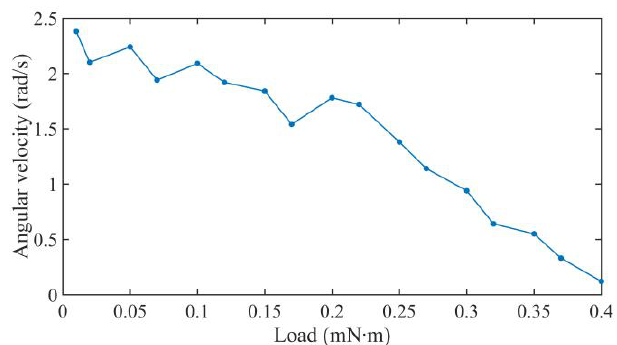
Figure 15. Rotational angle under different external loads at 8 kHz.